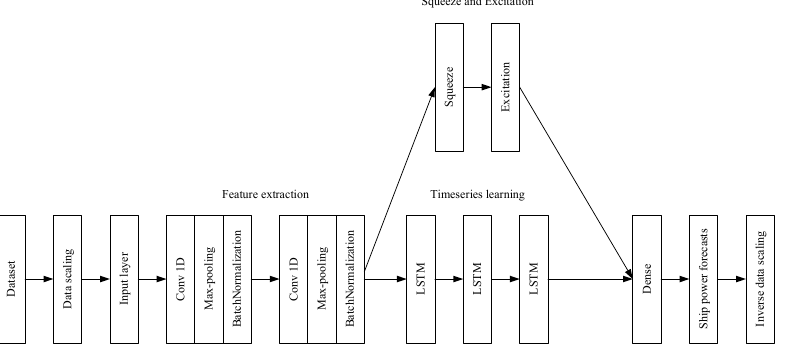
Figure 4. Convolutional neural network (CNN)-LSTM with squeeze and excitation (SE).